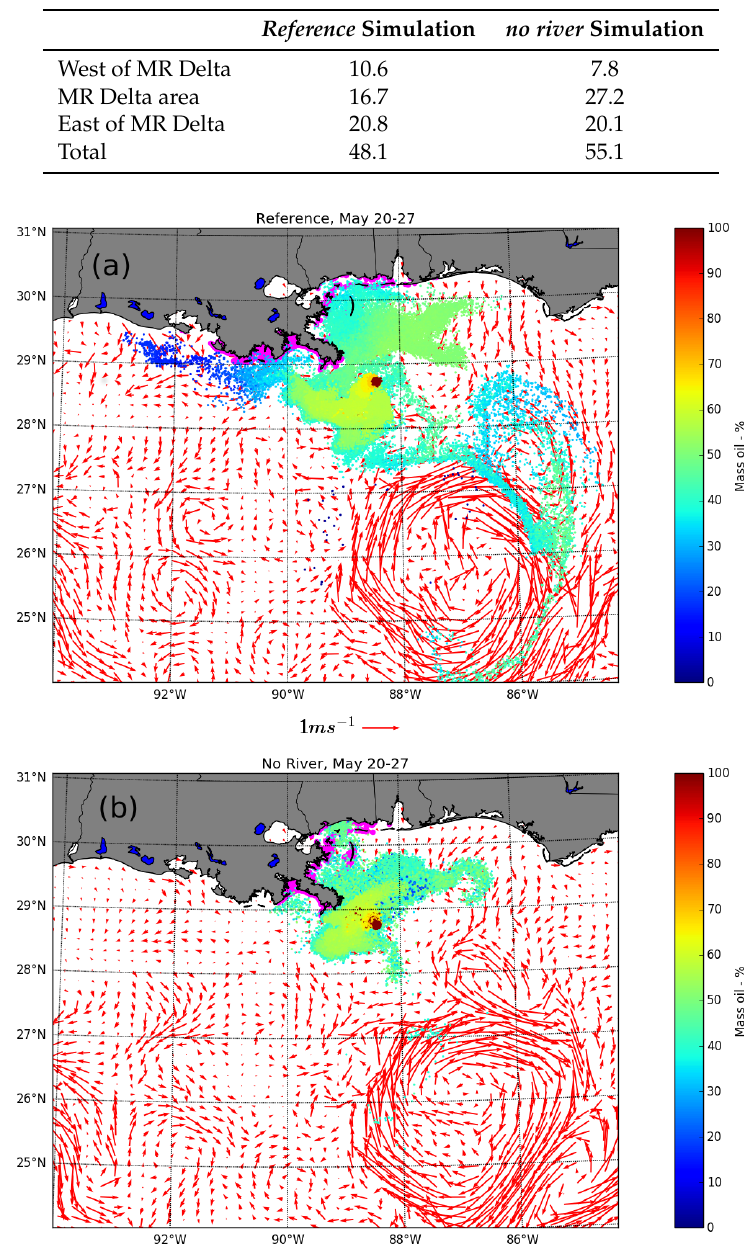
Figure 9. End condition of the simulation 20–27 May 2010, showing active (at surface) and stranded oil elements. Stranded oil is shown in magenta. The color scale indicate how much mass is left in each element. Red arrows are the GoM-HYCOM 1/50 forcing surface currents at the last time step of the simulation (every 5th data point shown). Reference simulation in ( a ) (12.1% stranded oil), and no river simulation shown in ( b ) (6% stranded oil) (see also Table